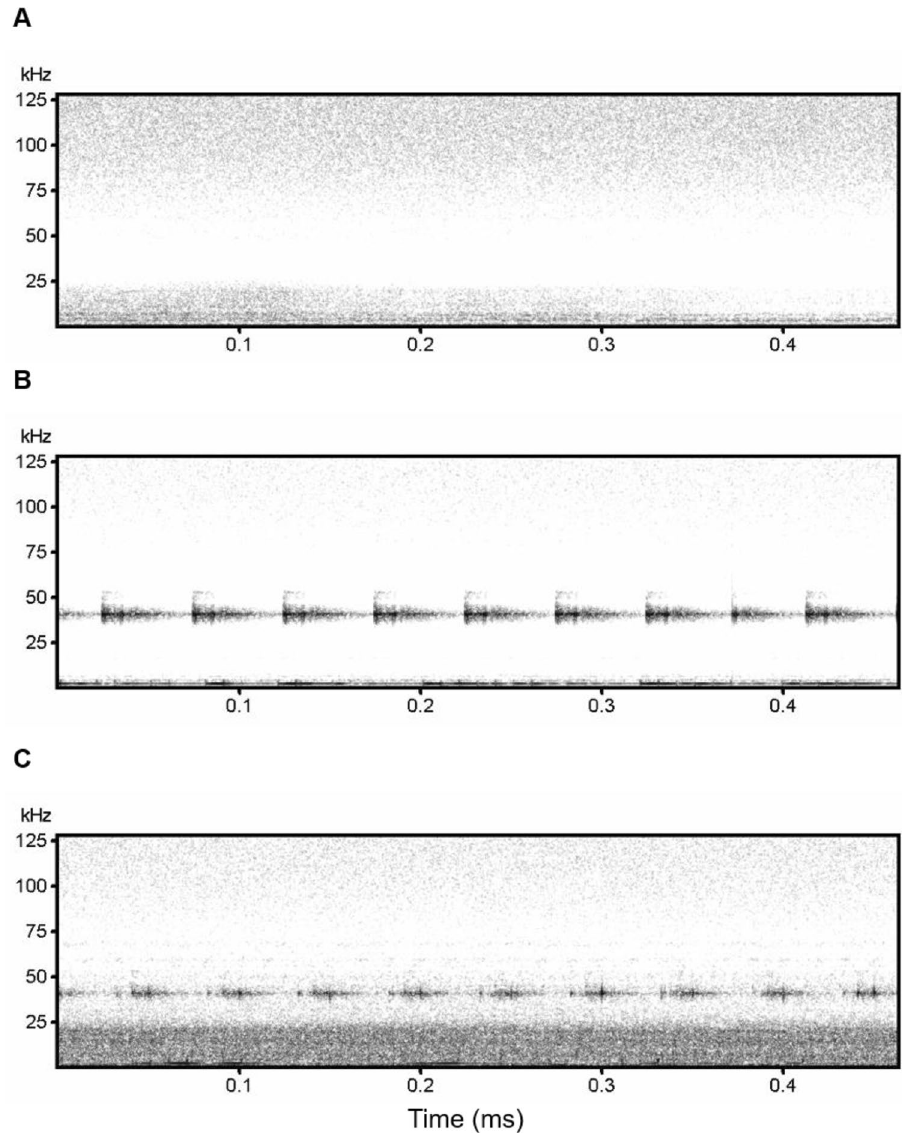
Figure 5. Spectrographs of possible noise interference sources from the unmanned aerial vehicle. Spectrographs of ( A ) ambient noise, ( B ) drone motor noise and ( C ) the flying drone. Spectrographs were generated in SASLab